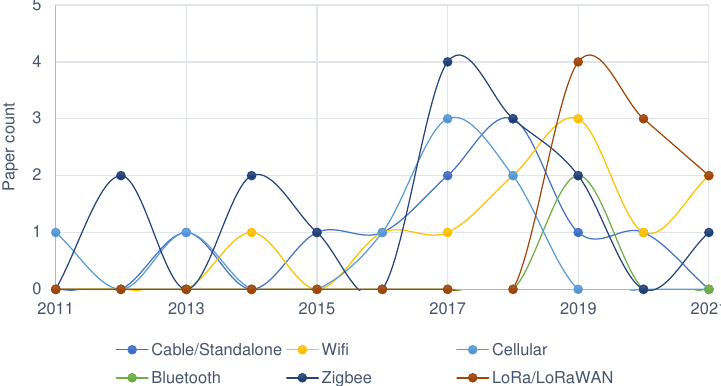
Figure 6. Wireless communication technology preference trends of the reviewed works for small- holder agriculture applications. The Y–axis denotes number of works using a specific communication technology. Some papers have used multiple of this technology, simultaneously.